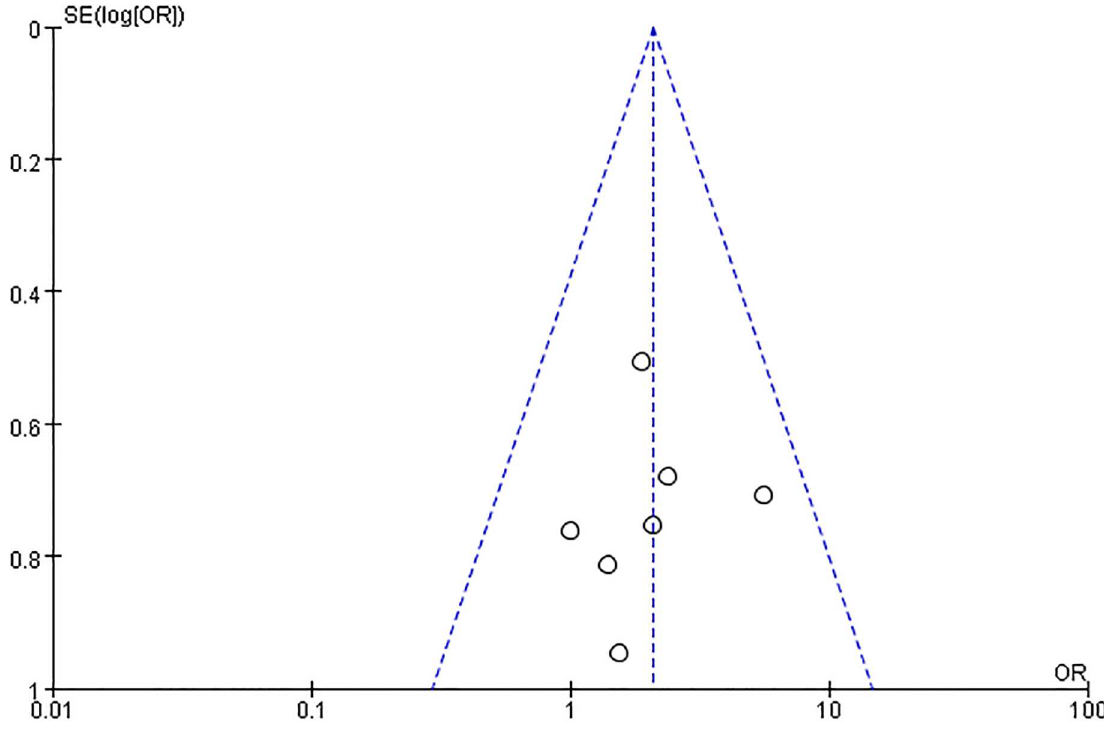
Fig 7. Clinical effectsin the intervention